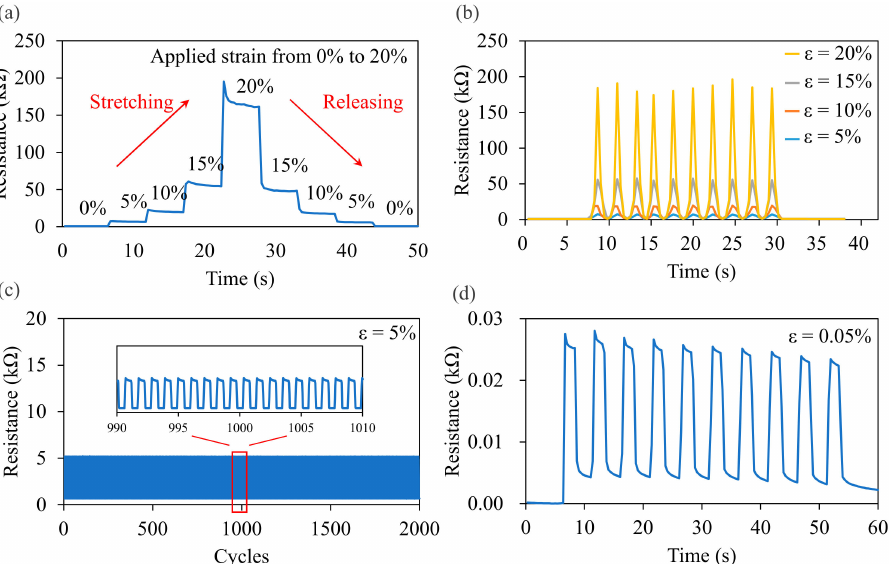
Figure 12. Performance of the parallel LIG strain sensor for ( a ) step response, ( b ) dynamic response, ( c ) durability testing, and ( d ) minimum sensing strain